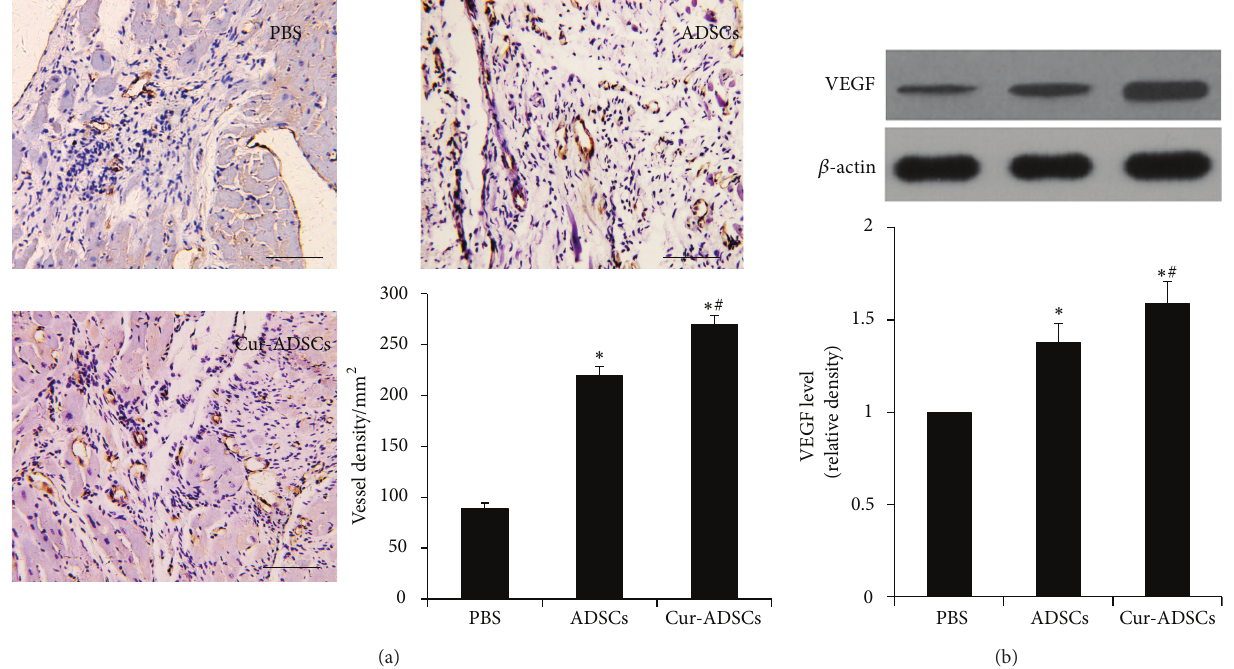
Figure 6: Assessment of vessel density at the border zone of MI and VEGF level in ischemic myocardium. (a) Representative anti-vWF antibody staining images by immunohistochemistry and quantitative analysis revealed microvessel density was the highest in the Cur-ADSCs group ( 𝑃 < 0.05 ). (b) Representative Western blots of VEGF expression level and quantitative analysis showed curcumin pretreatment significantly VEGF level in ischemic myocardium. 𝛽 -actin is used as internal parameter. Scale bars = 100 𝜇 m. Statistical differences ( 𝑃 < 0.05 ) are indicated from PBS ( ∗ ) and ADSCs